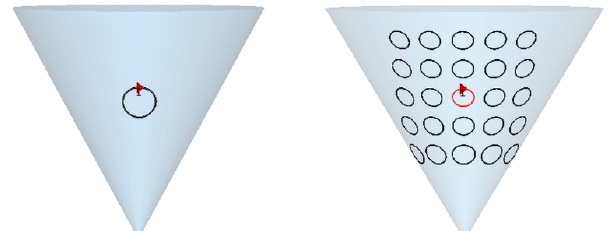
Fig. 8. Curved loop wire (left panel) and array of 5x5 loop elements (the central one is fed) (right panel)